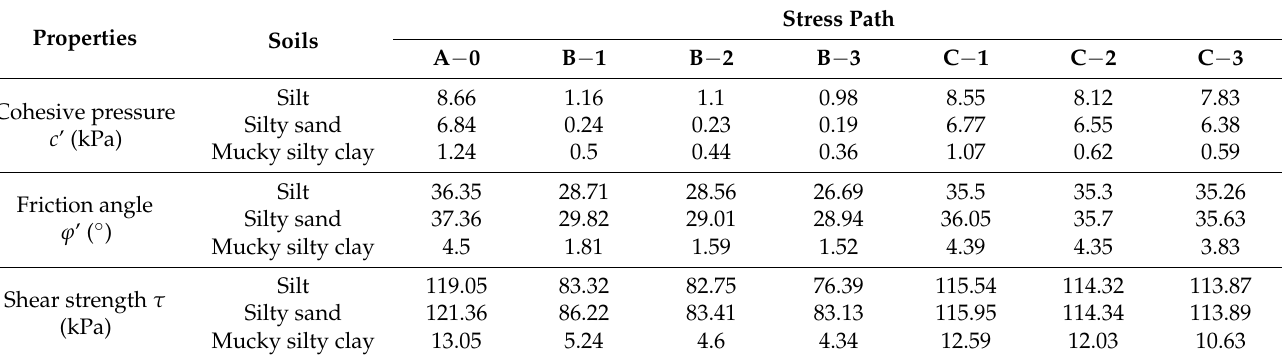
Table 5. Shear strength indicators of soil under different unloading intensity